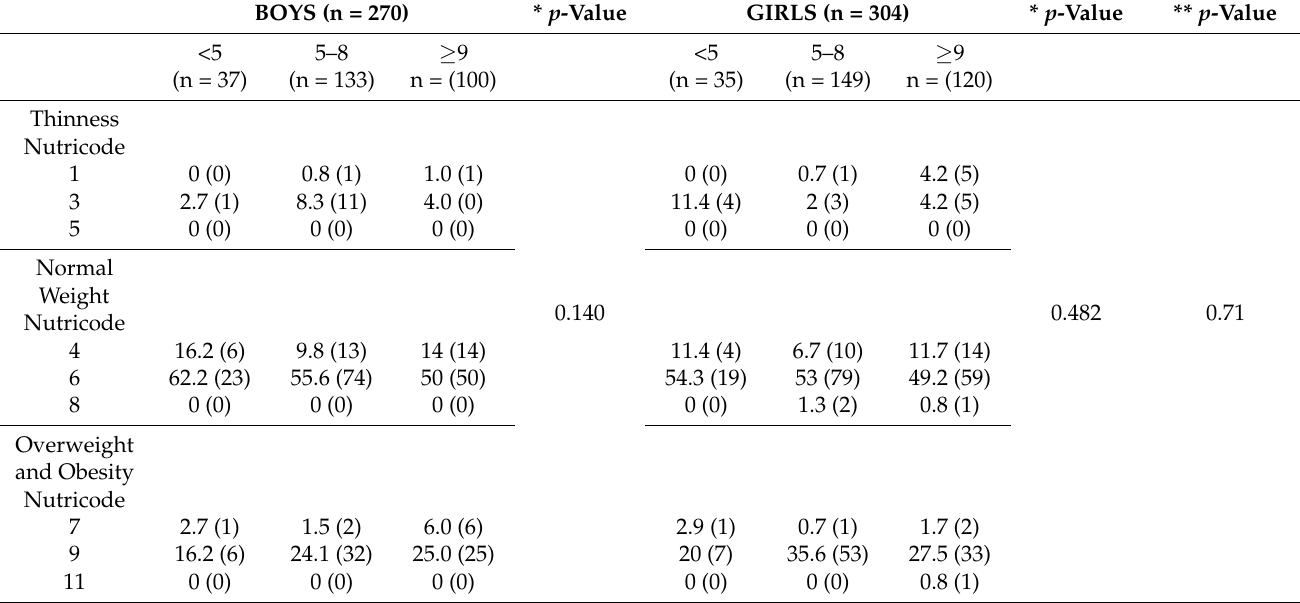
Table 4. Frequencies (%) of the studied population according to codes established for